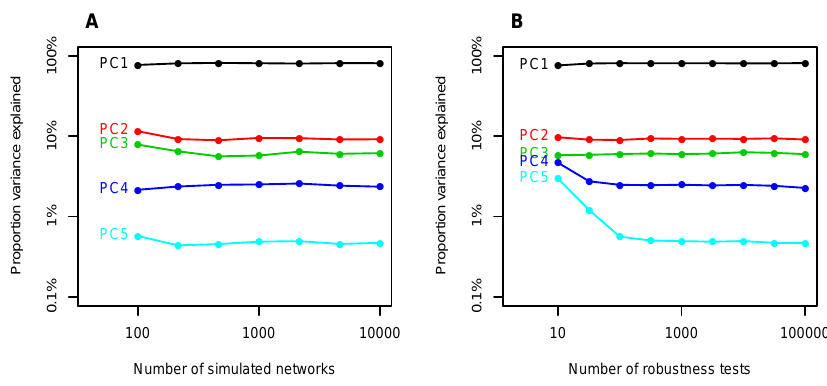
Figure SI3 – Sampling effects on Principal Components. Influence of the sampling effect (number of networks and number of replicates R to estimate robustness) on the relative weight of the principal components. All PCs except the last one are robust to